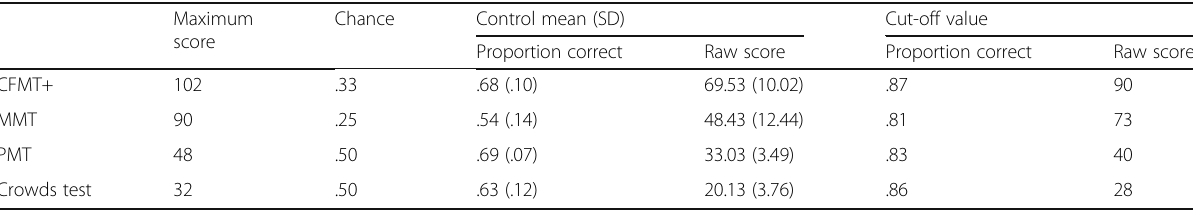
Table 1 Control norms ( N = 40) for overall performance on each test